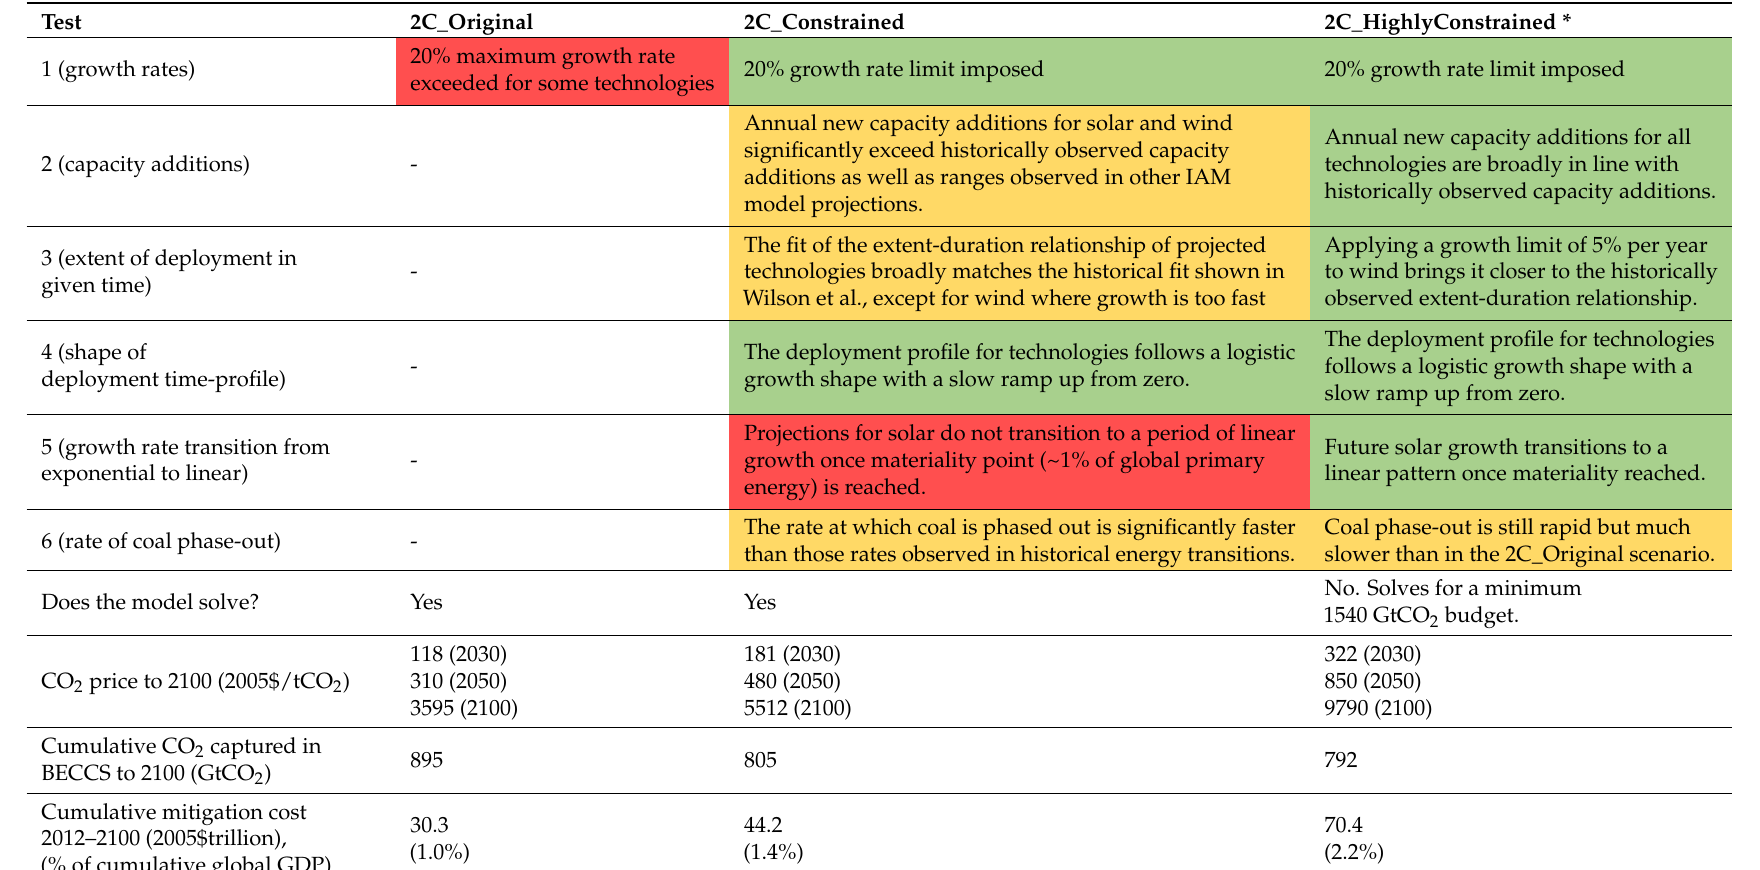
Table 5. Summary of outcomes from the diagnostic